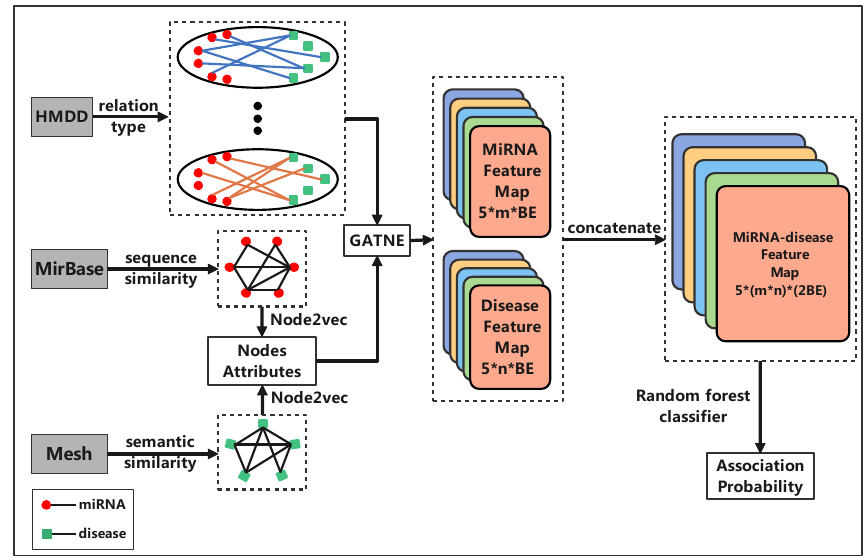
Figure 4. An illustration of predicting multiple types of miRNA-disease associations by mDLinker. There are m miRNAs, n diseases and five layers in the network representing the five types of associations. BE is the dimension number of the miRNA vector representation and also the dimension number of the disease vector representation embedded by